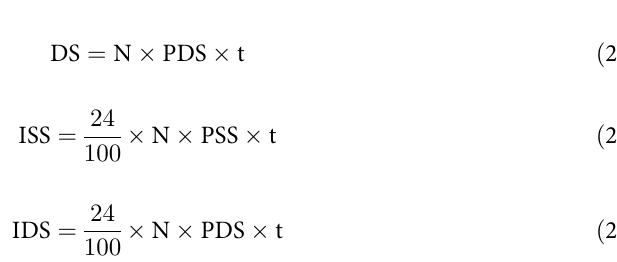
(20), (21), (22) and (23) are used for computation.